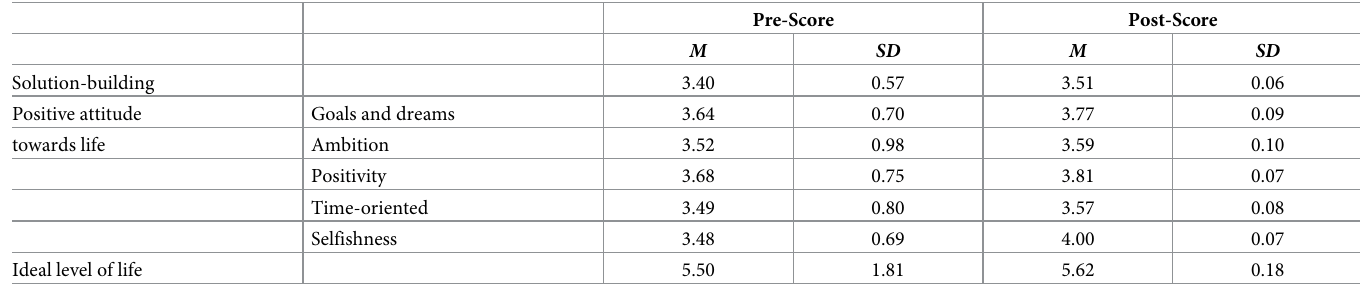
Table 1. Descriptive statistics of